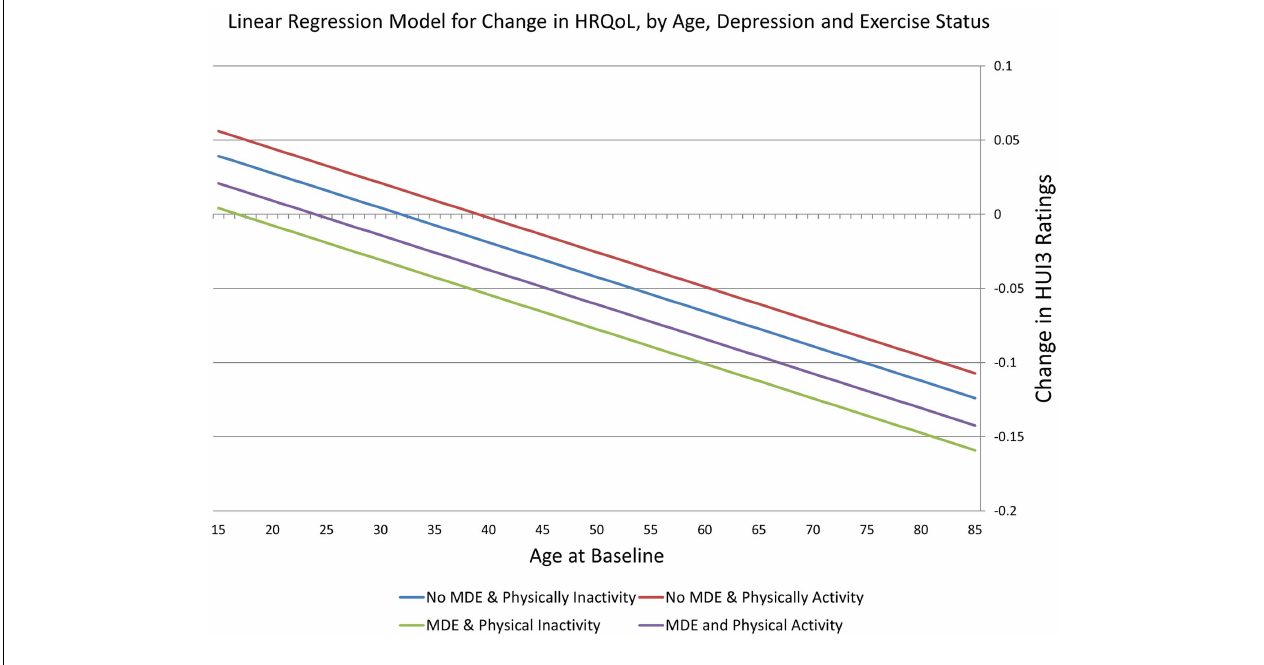
FIGURE 1 | Linear regression model for change in